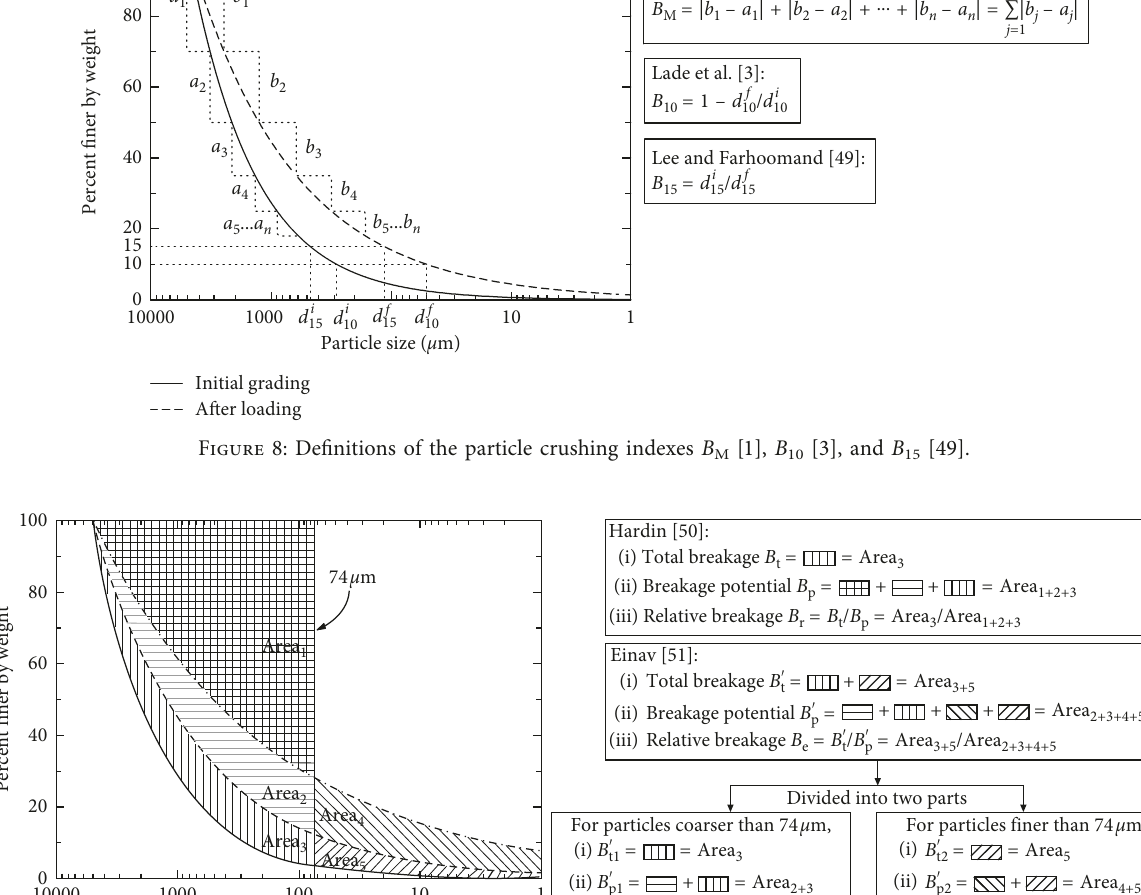
r [50] and B e [51] and the division of B e